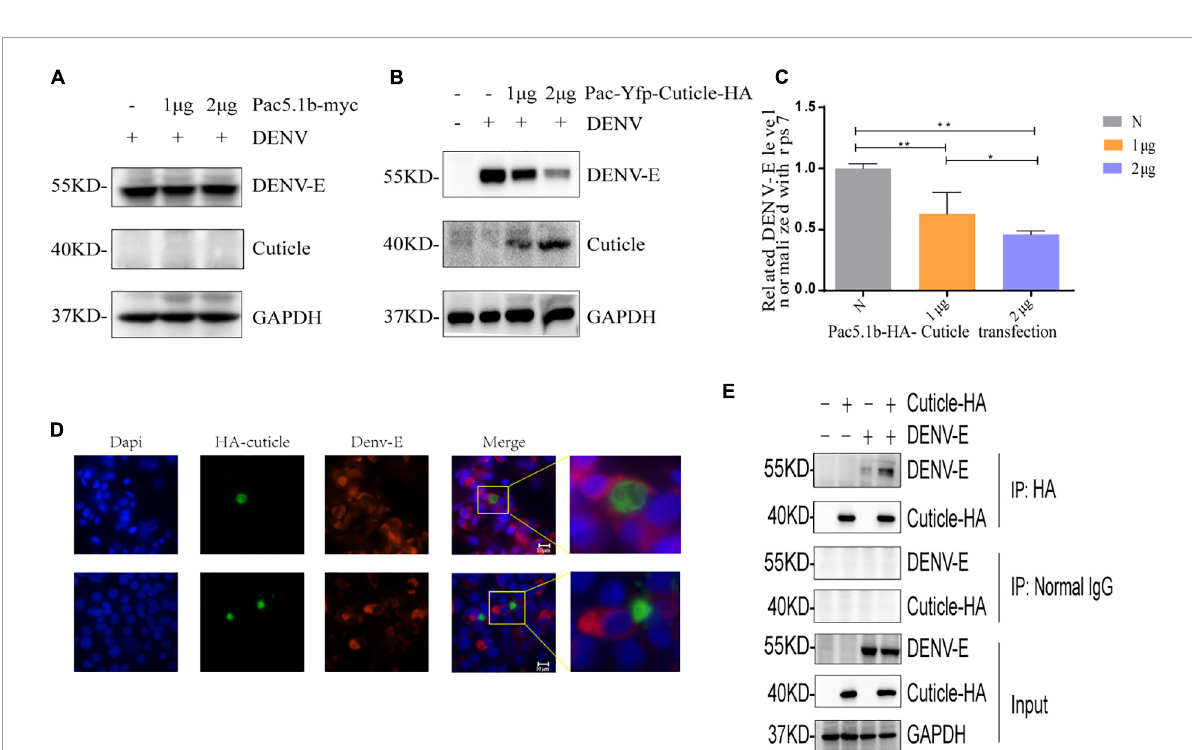
FIGURE5 PC protein inhibits the expression of DENV-E protein. (A) Empty vector were transfected into C6/36 cells, and cells were inoculated with DENV (MOI = 1) 48 h after transfection, lysates of C6/36 cells at 24 hpi were detected by SDS-PAGE and WB using the antibodies as indicated. (B,C) 0, 1, 2 µ gpAC5.1b-myc-YFP-Cuticle-HA was transfected into C6/36 cells, respectively, and DENV (MOI = 1) was infected 48 h after transfection. The cells’ RNA and protein were extracted from the cells at 24 hpi and detected by qRT-PCR and WB as indicated, respectively. (D) BHK-21 cells were transfected with pcDNA3.1(+)-YFP-Cuticle-HA plasmids and infected with DENV (MOI = 1) at 24 h after transfection. Cells were fixed at 24 hpi, and incubated with a DENV-E protein monoclonal antibody and the corresponding fluorescent secondary antibody. A YFP-PC-HA fusion protein was expressed to detect PC protein (green), localization of DENV-E was detected with antibodies to fluorescent secondary antibody (red), nuclei were stained with DAPI (blue). The upper and lower images in each column are of two fields of view in the same slide. (A,E) COS7 cells were transfected with pcDNA3.1 (+)-YFP-EEV6-HA plasmid and infected with DENV (MOI = 1) at 24 h after transfection, and proteins were extracted at 24 hpi for WB and Co-ip analysis. All experiments were performed at least three times, *denotes a P- value < 0.005, **denotes a P- value <